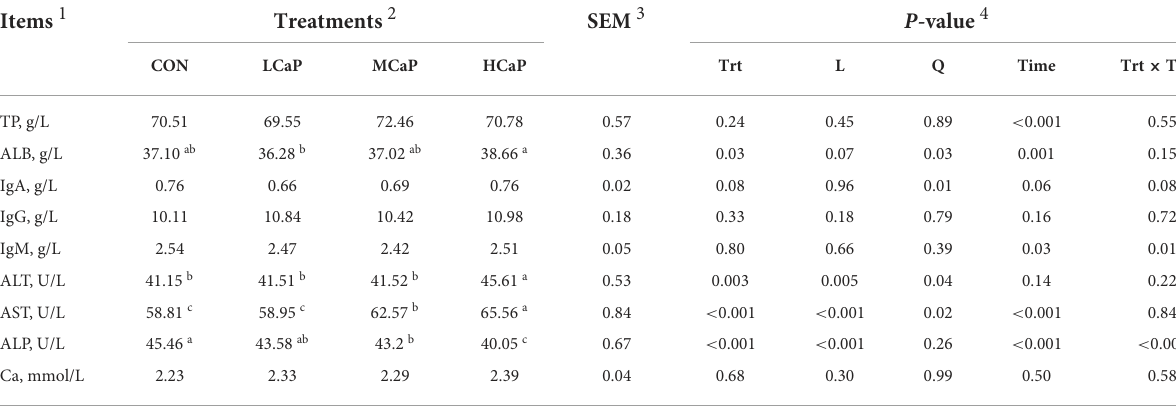
TABLE 2 Effects of calcium propionate feeding levels on serum immune and liver function of dairy cows in early lactation.